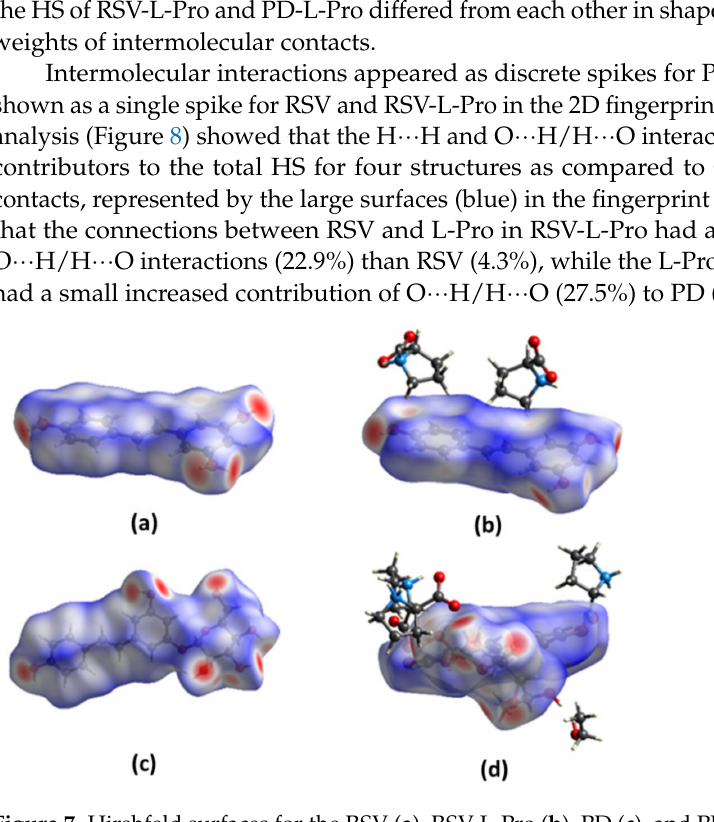
Figure 7. Hirshfeld surfaces for the RSV ( a ), RSV-L-Pro ( b ), PD ( c ), and PD-L-Pro ( d